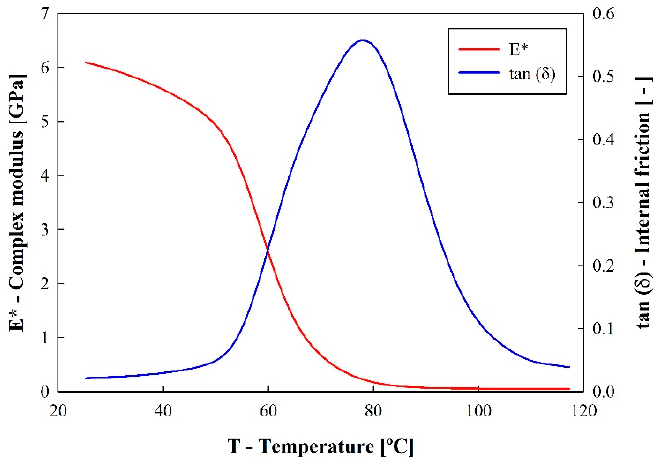
Figure 5. Average results of DMA testing.